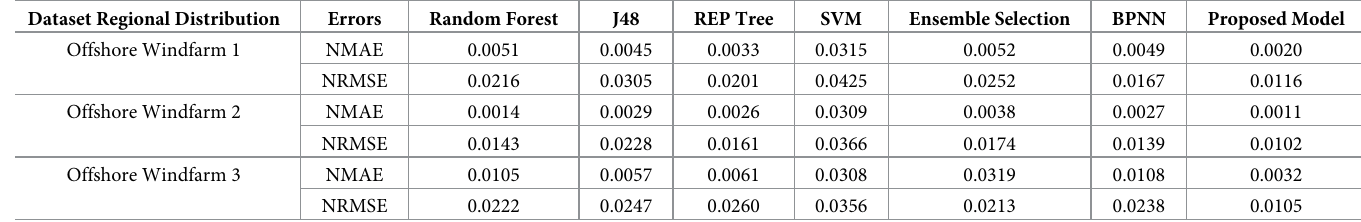
Table 6. Comparison of the normalized mean absolute error (MAE) and normalized root mean square error (RMSE) of the proposed model with other state-of-art forecasting methods for all three offshore windfarms.